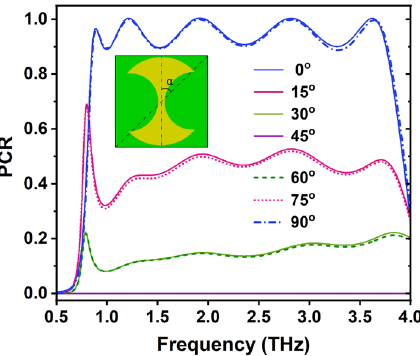
Figure 12. Dependence of PCR on rotation angle ( α ) under normal incidence. The rotation angle ( α ) is the angle between the long base line of the gold resonant patch and the diagonally of the unit cell.